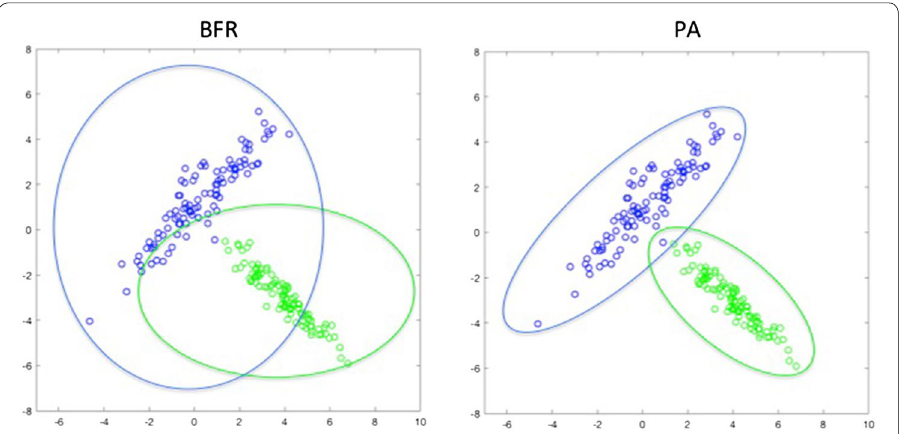
Fig. 4 Example of a typical situation in 2D: the BFR algorithm is approximating the shape of the clusters using ellipsoids parallel to the main axes. Our proposed algorithm (PA) is using ellipsoids with the correct orientation, thus the uncertainty region (overlapping of the ellipsoids) is